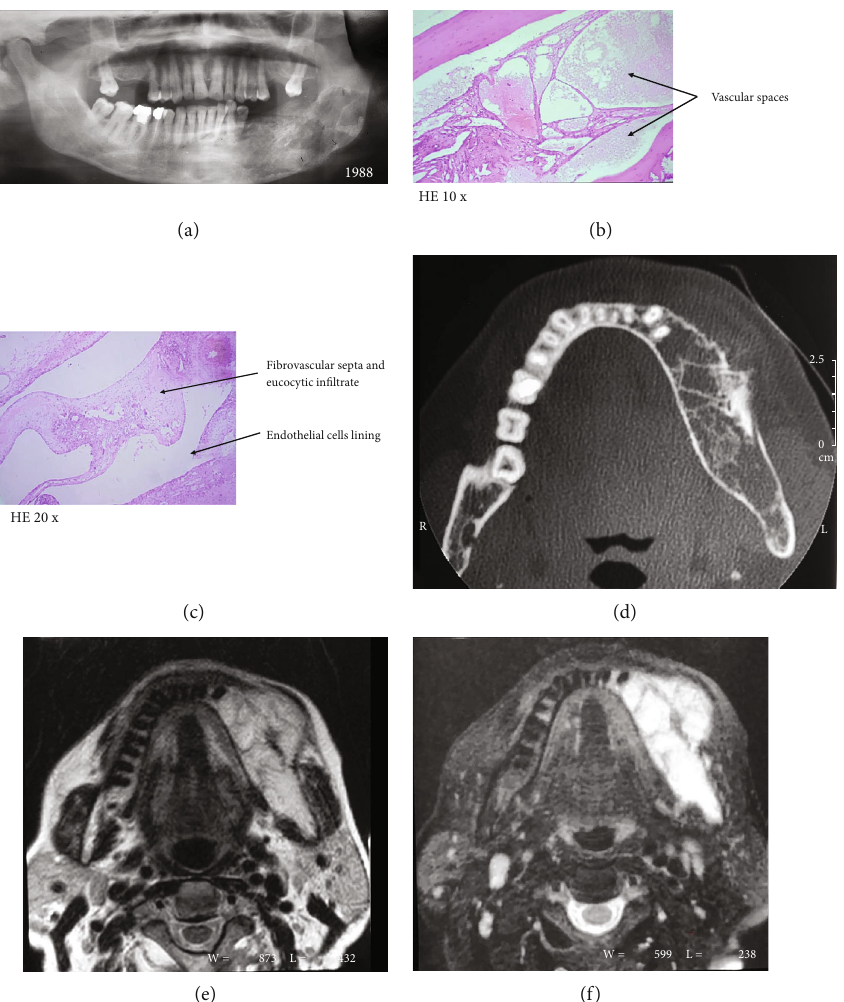
Figure 2: (a) Panoramic radiograph showing a well-de fi ned multilocular radiolucency extending from the mental nerve region to the ramus. (b) Thin-walled and dilated vascular spaces of variable diameter (HE × 10). (c) Regular endothelial lining of the vascular spaces with mild in fl ammatory polymorphous leucocytic in fi ltrates in the surrounding tissue (HE × 20). (d) An axial CT image showing an expansible multilocular radiolucency lesion with periosteal reaction on the buccal cortex. (e) An axial T2WI MR image revealing a hyposignal intensity expansible low-intensity lesion in the marrow of the left hemimandible with cortical rupture and soft tissue extension. (f) An axial T2 WI FSE image presented a hypersignal and expansible lesion with internal loculations suggesting a multilocular